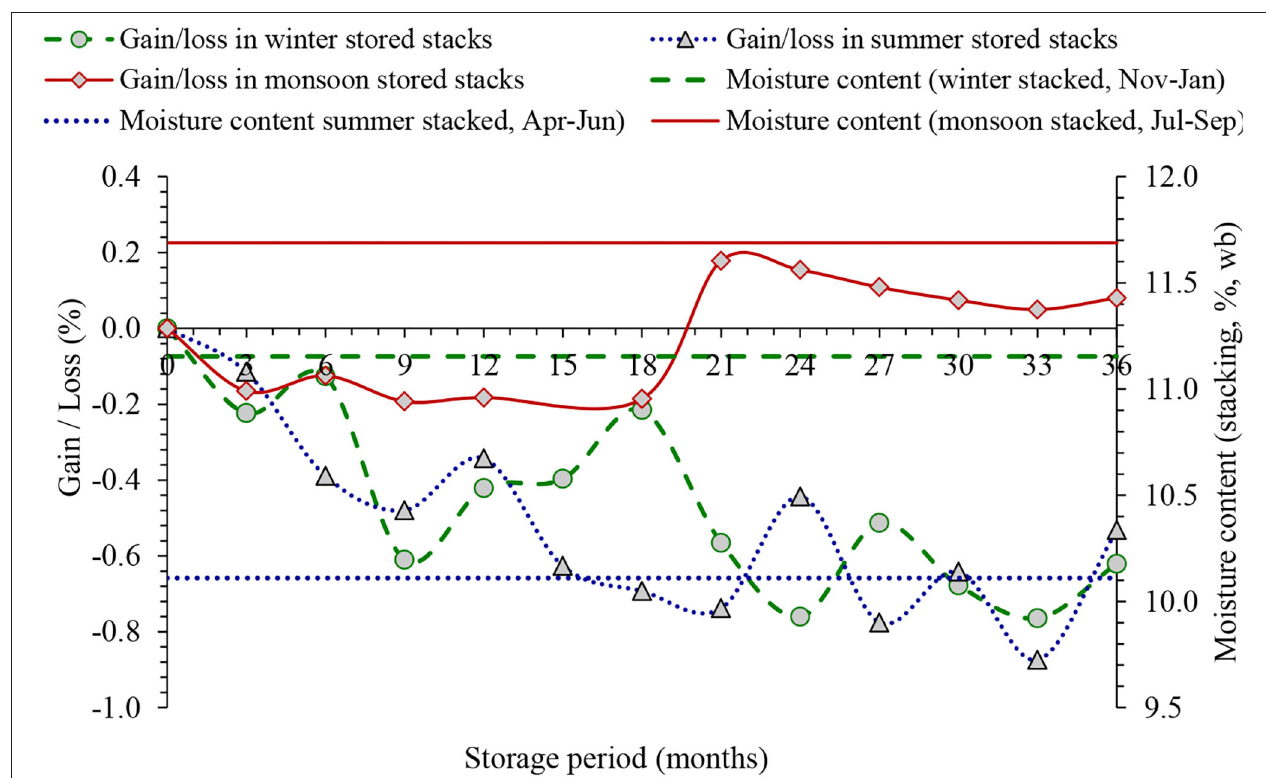
FIGURE 8 | Effect of stacking moisture content and season of storage on gain/losses during storage of wheat in procuring